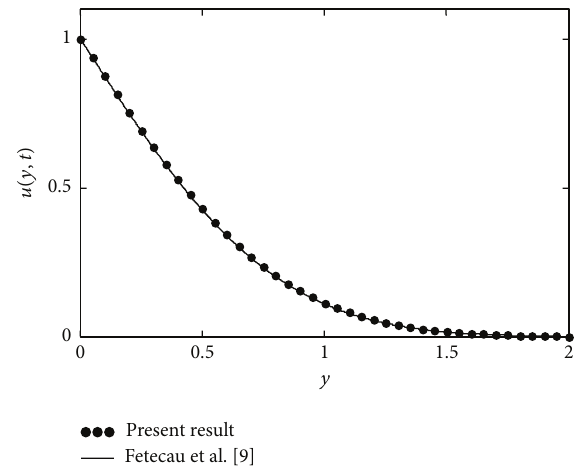
Figure 2: Comparison of the present results (see (24)) with those obtained by Fetecau et al. [9] (see (9) and (11)), when 𝑡 = 0.2 , 𝜔 = 0 , 𝑎 = 1 , 𝑈 = 1 , and V = 1 .